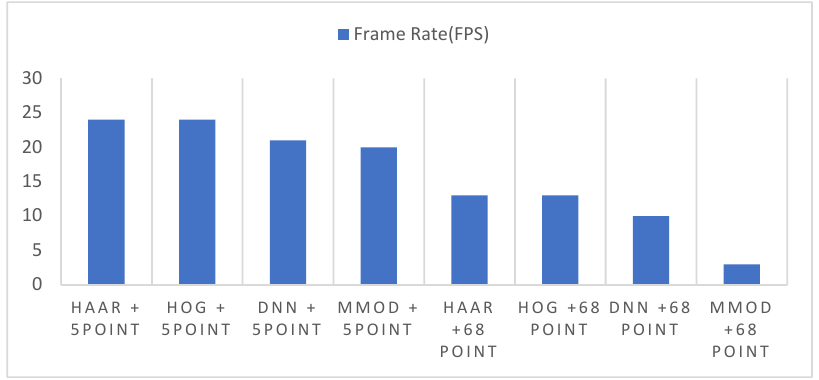
Figure 10. Speed comparison for the four methods detecting 5 and 64 feature points